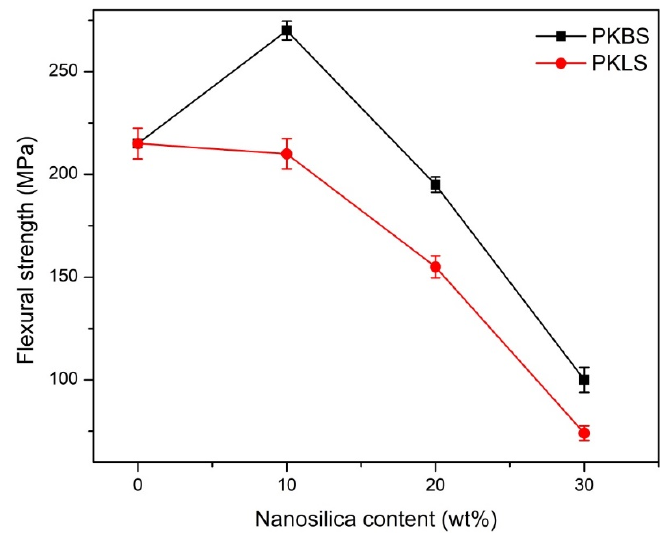
Figure 7. Mean value and standard deviations (mean ± SD) of flexural strength for the PEEK/SiO 2 nanocomposites as a function of the nano-SiO 2 content. ( n = 7).